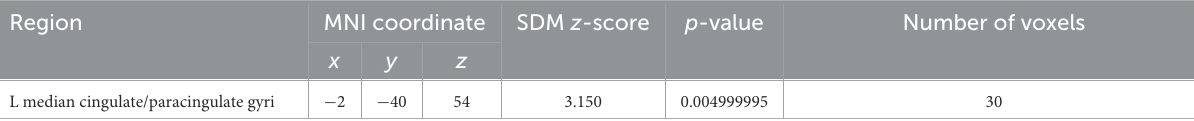
TABLE 5 Meta-regression analysis of VAS scores in treatment group. Region